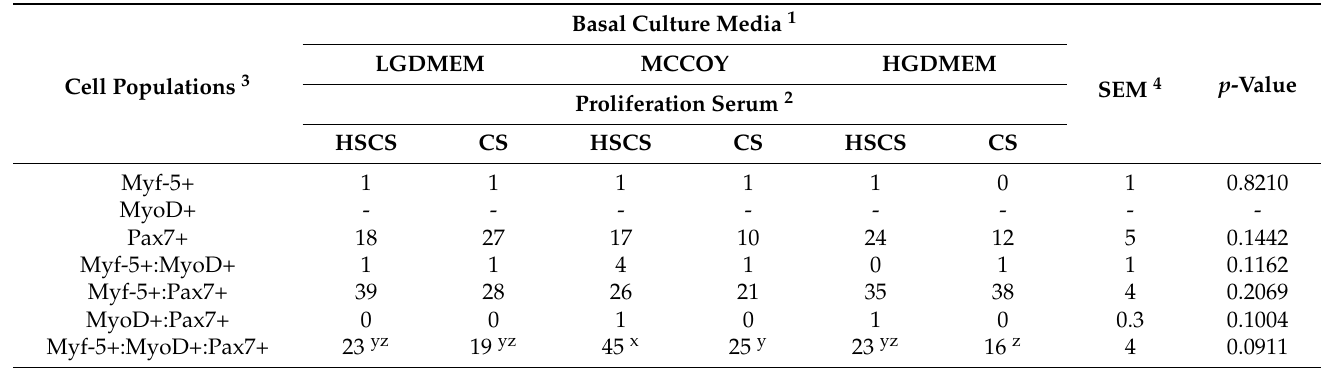
Table 1. The effect of basal culture media and proliferation serum on proliferating satellite cells heterogeneity at 48 h post-plating.